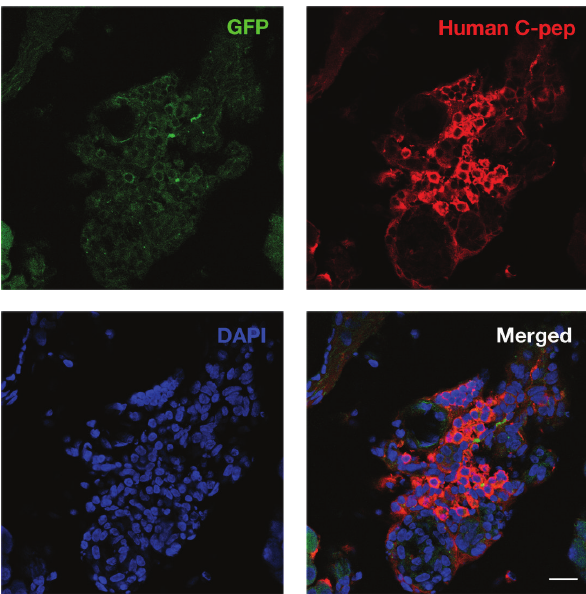
Figure 5: WJ-MSCs differentiated into IPCs and resided in the pancreas of the STZ rat. Confocal analysis of the pancreas tissues 23 days after WJ-IPCs transplantation showed clusters of cells with GFP expression and human C-peptide expression (red) as well as the nuclear stain, DAPI (blue). Scale bar = 50 𝜇